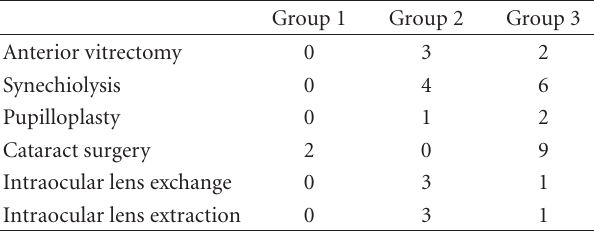
Table 2: The number of eyes that underwent additional procedures during penetrating